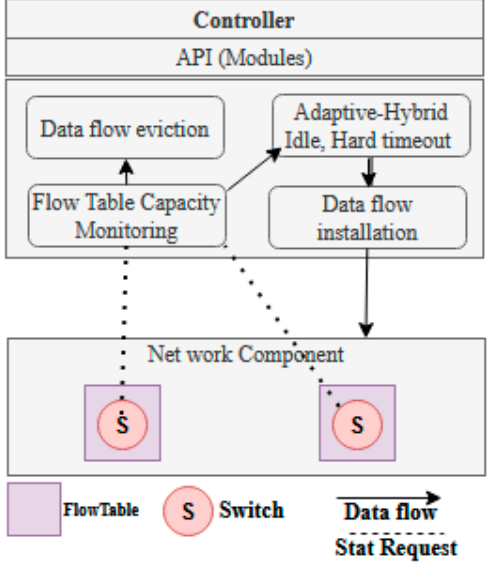
Figure 4: Modules of the proposed solution Figure 4. Modules of the proposed